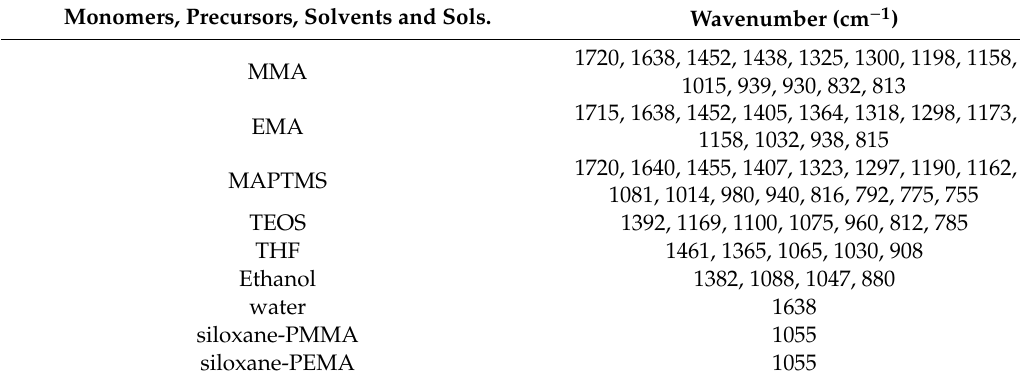
Table 2. The main bands in FTIR spectra for initial MMA and EMA monomers, TEOS and MAPTMS precursors, siloxane-PMMA and siloxane-PEMA sols and solvents. Monomers, Precursors, Solvents and